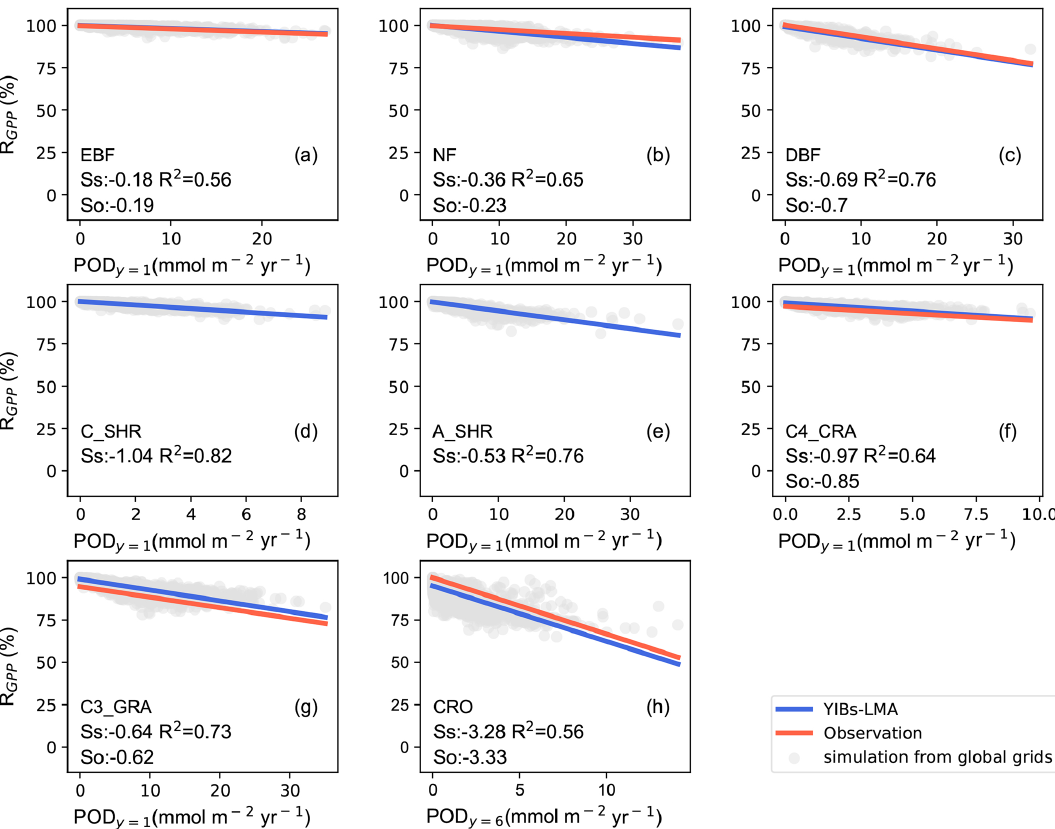
Figure 4. Comparisons of observed and simulated dose–response relationships. Simulated PFT-specific DRRs are derived from YIBs-LMA with gridded LMA from M2018, x = 0 . 019nmolg − 1 s − 1 , and a = 3 . 5nmol − 1 sg. Each dot represents results from a grid cell with corre- sponding PFT. The regressions between relative GPP percentage ( R GPP ) and leaf area-based stomatal O 3 uptake fluxes (POD y = 1 for natural PFTs and POD y = 6 for crops) are shown for observations (red; see Table S1) and simulations (blue) with slopes of DRRs denoted as S O and S S , respectively. S O values are missing for (d) cold and (e) arid shrubs. Coefficients of determination ( R 2 ) of simulations are displayed in each panel. Note the differences of ranges in x axis among PFTs (PFTs are shown in Fig. S1).